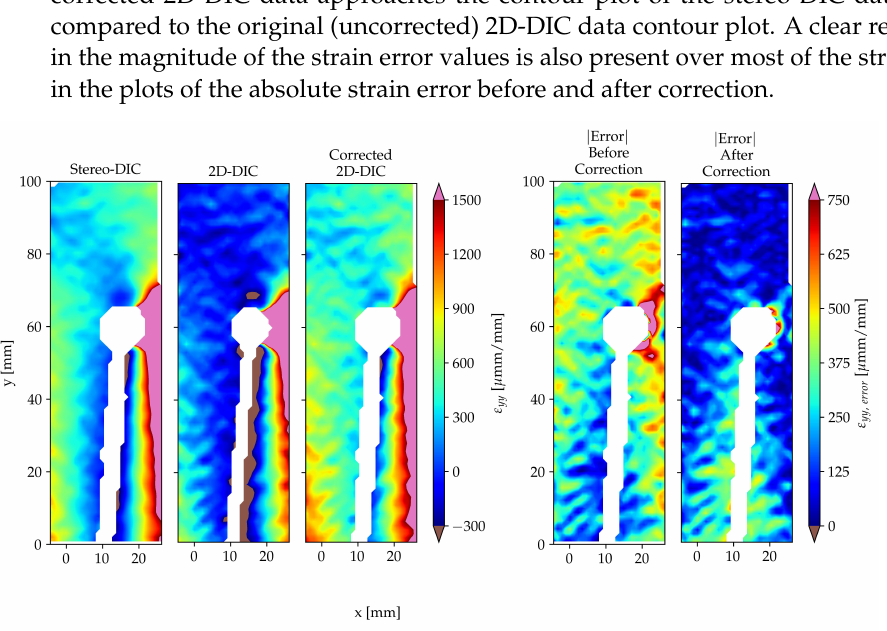
Figure 9. Contour plots of the stereo-DIC, 2D-DIC, corrected 2D-DIC and error data for strain in the y-direction for the 700th image of Test